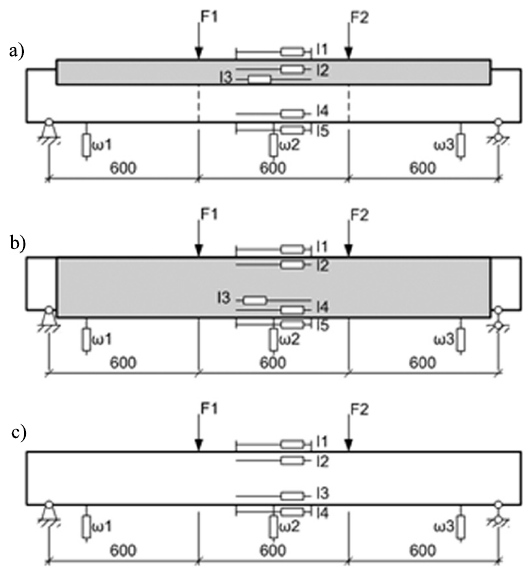
Fig. 6. Testing schema of the beams and arrangement of mea- suring devices: (a) SxT beams, (b) SxU beams, (c) Sx